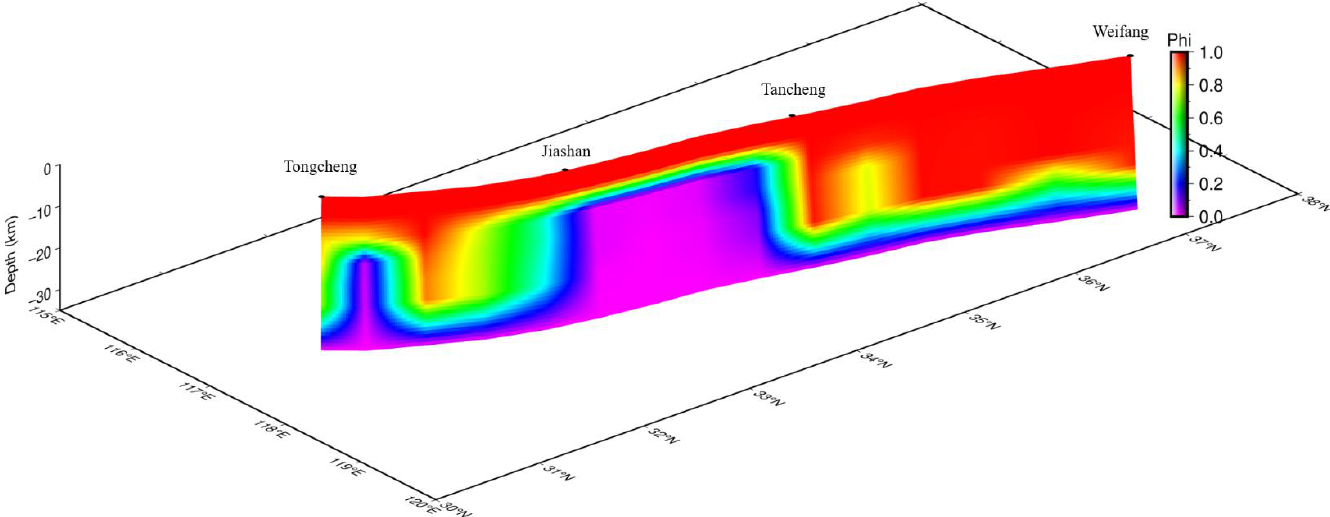
Figure 4. The three-dimensional (3D) spatial distribution of coupling ratios of the optimal model inverted by AHCORS and CMONOC velocity field. Purple to red indicates the fault coupling coefficient. The red places indicate that the fault is fully locked, and the purple places mean that the fault is freely creeping; other colors suggest that the fault is partly locked.